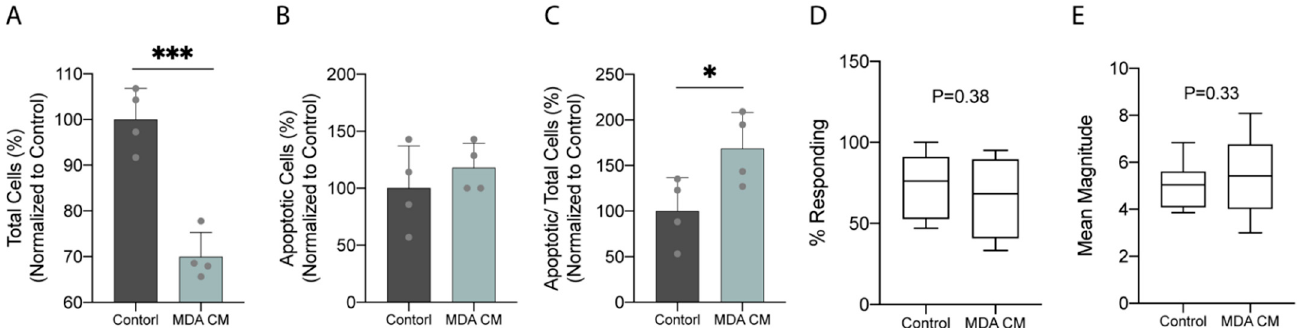
Figure 6. Breast cancer cells induced the apoptosis of osteocytes through secreted factors and showed no effect on the intracellular calcium influx of osteocytes. ( A ) Total MLO-Y4, ( B ) apoptotic MLO-Y4, and ( C ) apoptotic MLO-Y4 over total MLO-Y4 after 3-day incubation of MLO-Y4 in CM from non-stimulated MDA-MB-231 compared to no CM control ( n = 4). ( D ) Intracellular calcium response percentage and ( E ) mean magnitude of MLO-Y4 under 2 Pa OFF after 3-day incubation of MLO-Y4 in CM from non-stimulated MDA-MB-231 compared to no CM control ( n = 13 for control, n = 16 for MDA CM group). *** p < 0.001, * p < 0.05.